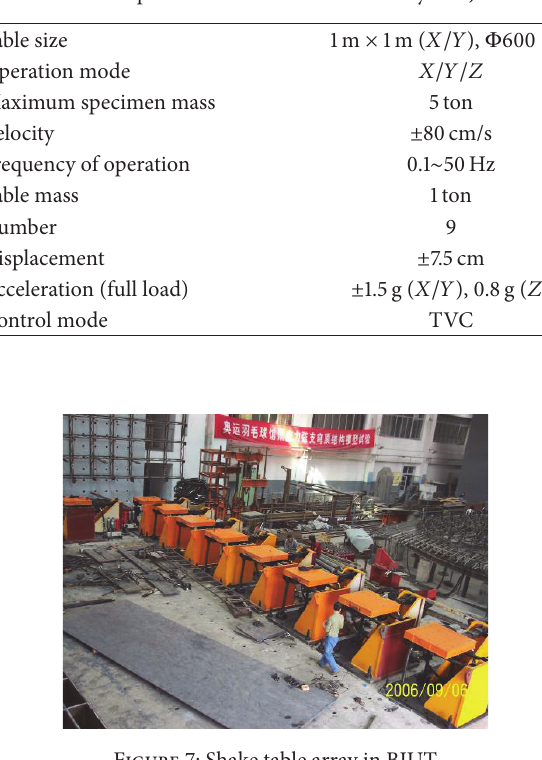
Figure 7: Shake table array in